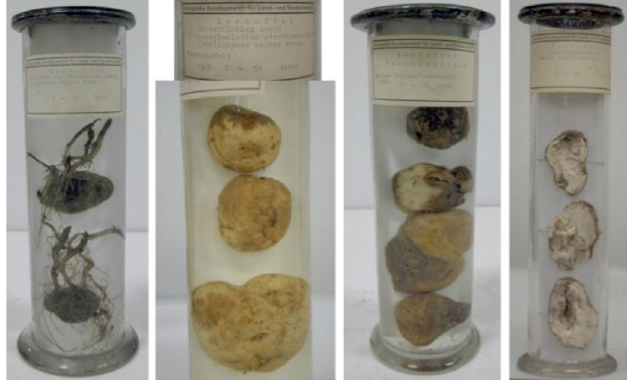
Fig. 4: Specimen of infected potato tubers preserved in formalin (collected and prepared by Otto Appel) − Left to right: Dying radicles caused by Rhizoctonia solani , Silver scurf caused by Spondylocladium atrovirens (= Helminthosporium solani ), two examples of Fusarium infested tubers (Phytopathological Collection of the Julius Kühn Institute; images by Manfred Gräfe und Djavad Taghizadhe, Stadtmuseum Berlin).